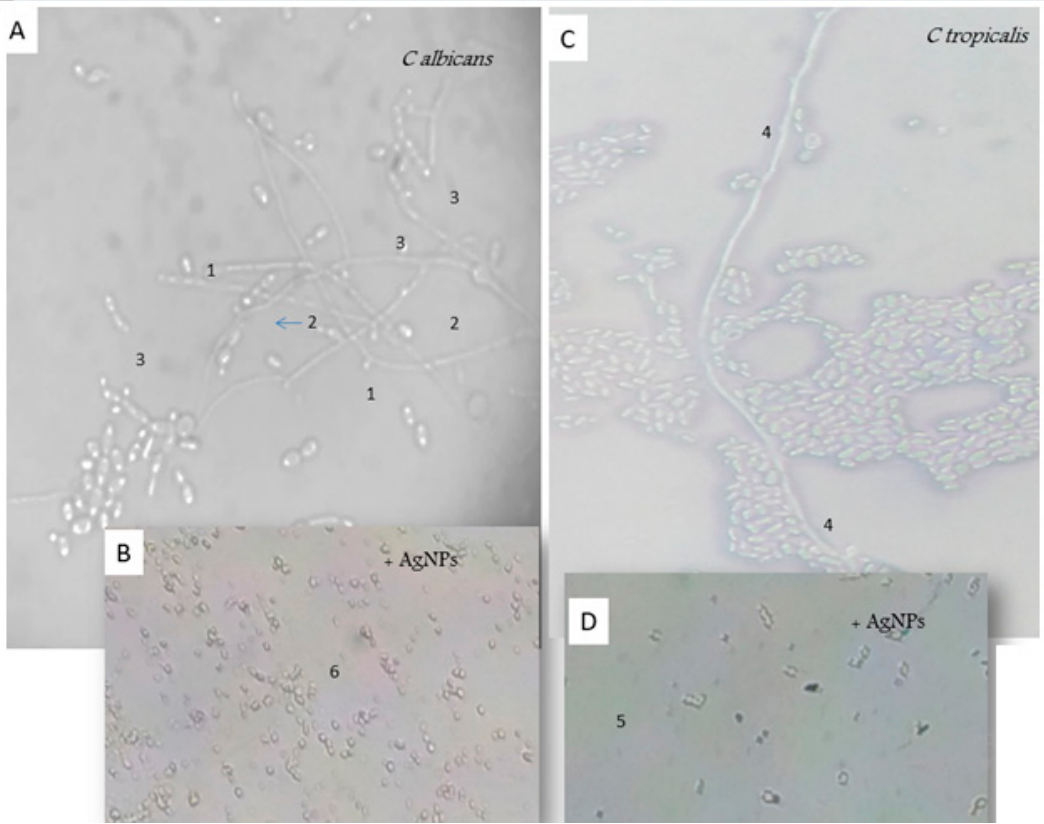
Figure 7. Comparative morphogenesis of Candida albicans growth without ( A ) and with ( B ) the addition of AgNPs and Candida tropicalis without ( C ) and with ( D ) the addition of AgNPs ( × 100 g). 1: germ tube, 2: clamydospore, 3: pseudofilaments, 4: real filaments, 5: blastospores and 6: altered blastospores.